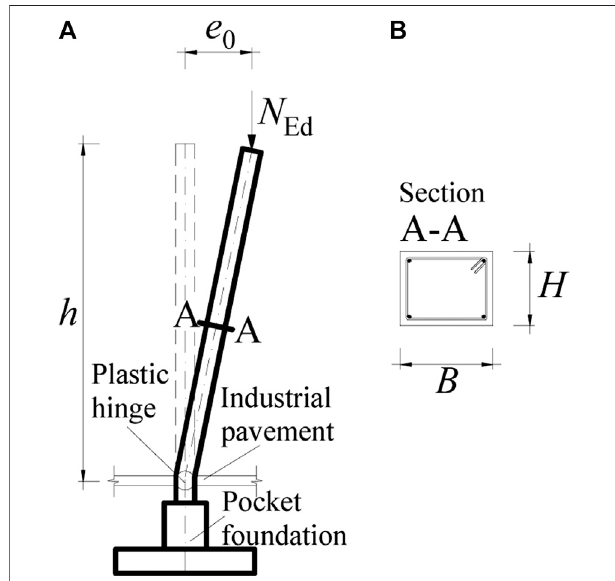
FIGURE 1 | Precast column with fl exural plastic hinge at the base: (A) elevation and (B) cross-sectional view. Longitudinal reinforcement comprised of four 18 mm-diameter corner bars ( A s (cid:1) 1,018 mm 2